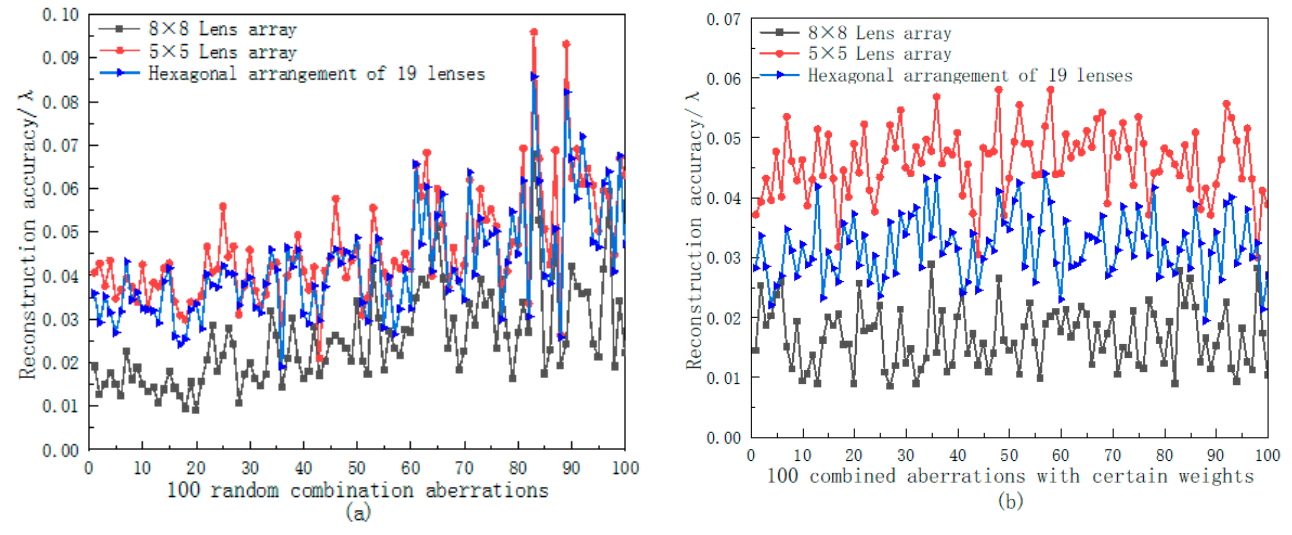
Figure 6. Simulation example of wavefront reconstruction: ( a ) hexagonal arrangement of 19 lenses; ( b ) 8 × 8 lens array; ( c ) 5 × 5 lens array.